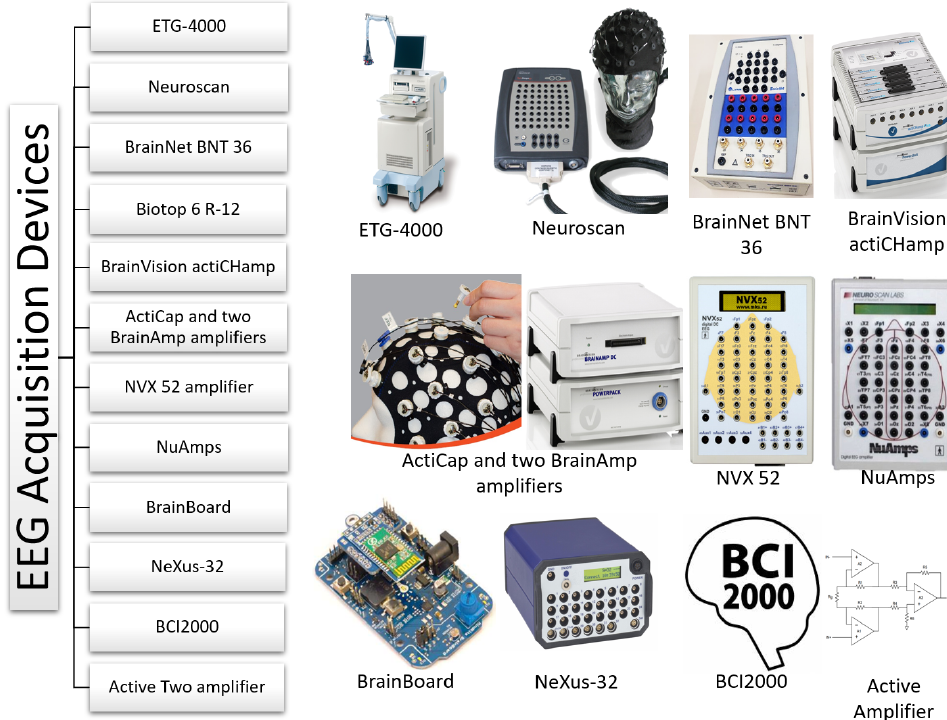
Figure 6. EEG Acquisition Devices used in reviewed works. Associated bibliographic